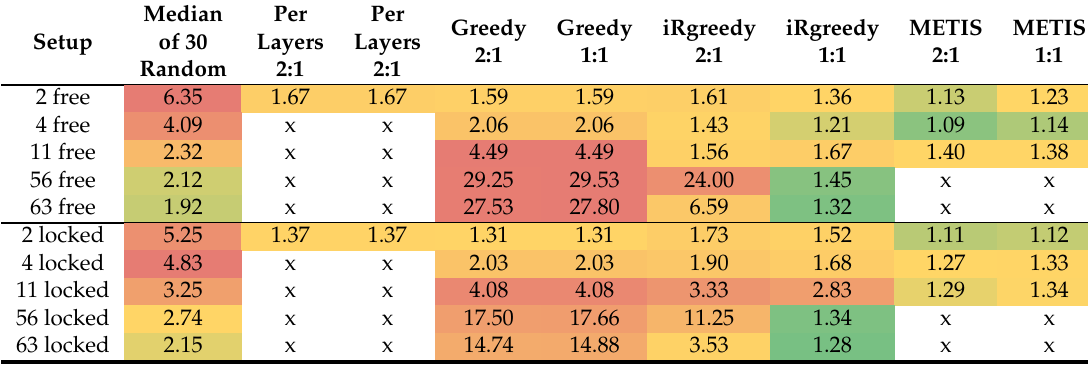
Table 6. Normalized results for DN 2 PCIoT 30R and DN 2 PCIoT after approaches. DN 2 PCIoT after per per Setup 30R Greedy